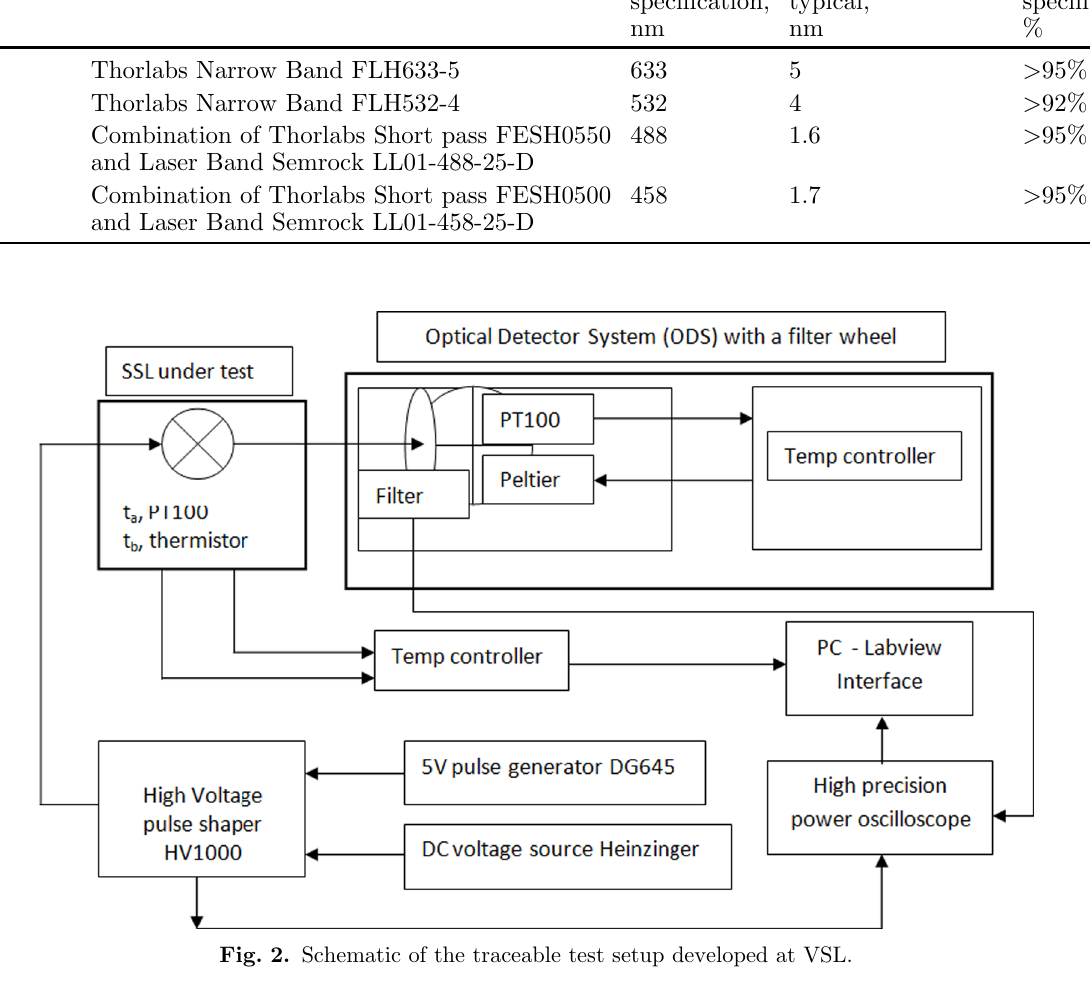
Table 1. Speci fi cation of the fi lters used in the fi lter wheel of the ODS. NN Filter, ODS Filter type and ID